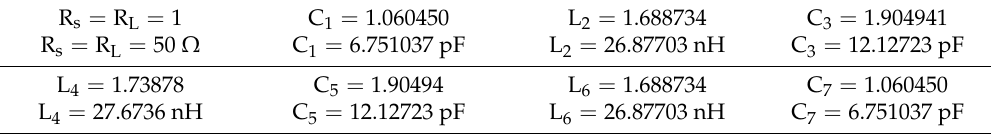
Table 3. Normalized and de-normalized values of passive elements for Pascal N = 7 and Amax = 0.5 dB [5]. R s = R L = 1 C 1 =